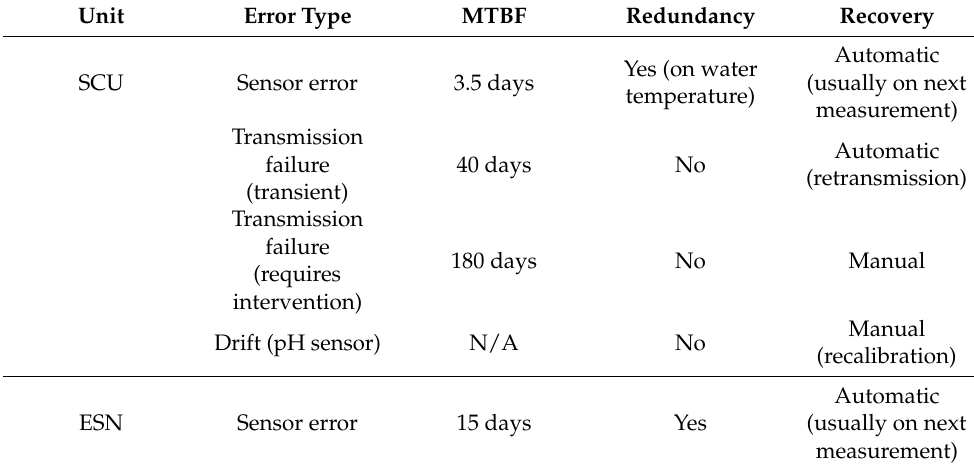
Table 5. Error summary.